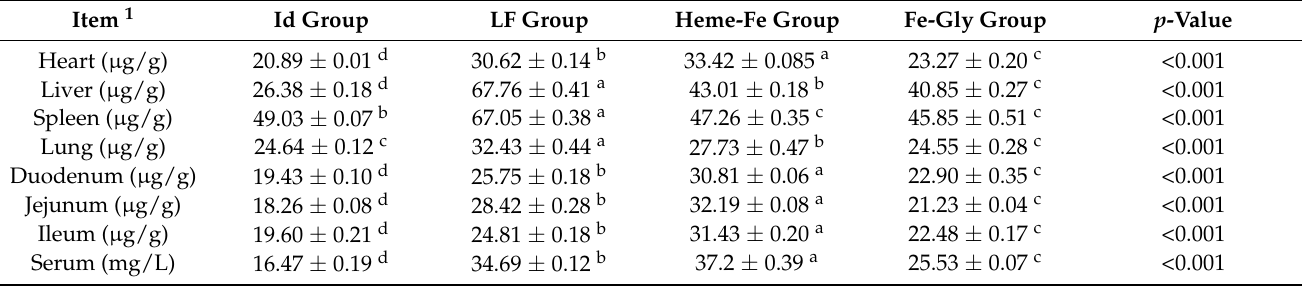
Table 5. Effects of different iron additives on iron content in newborn piglet